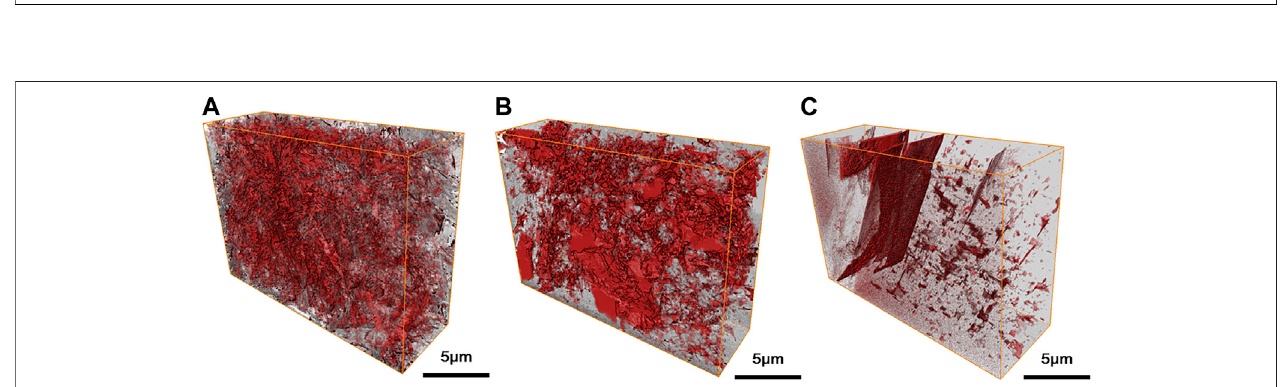
FIGURE 4 | 3D pore throat structure of core sample A, B and C (FIB-SEM).